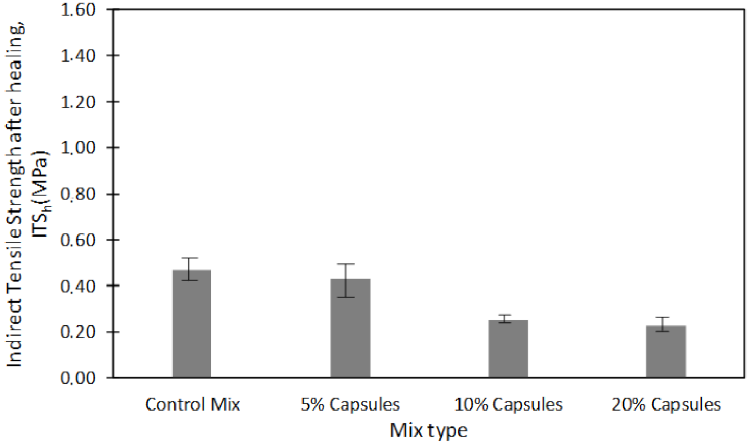
Figure 13. ITS results after